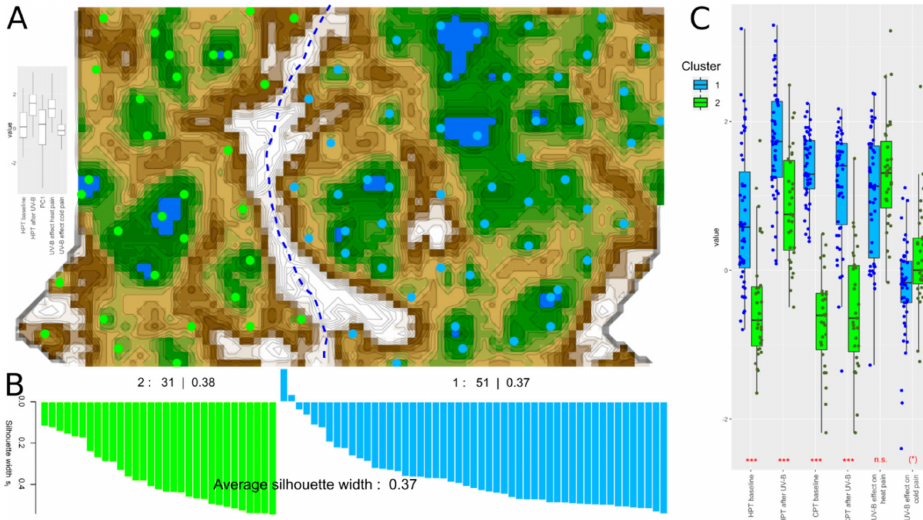
Figure 3. Neural network (emergent self-organizing maps (ESOM) / U-matrix)-based clustering [28] of the pain thresholds to thermal stimuli and the e ff ects of UV-B irradiation, exploring the 82 × 5-sized matrix composed of the values of zHPT baseline , zHPT UVB , UVBE ff Heat , and UVBE ff cold acquired or calculated in 82 subjects, and in addition to PC1 cold being the first component of a PCA of the highly correlated parameters zCPT baseline and zCPT UVB . ( A ) U-matrix visualization of distance-based data structures, using a projection of the data points onto a toroid grid of 4000 neurons where opposite edges are connected. The dots represent the so-called “best matching units” (BMU)—i.e., neurons on the grid that after ESOM learning carried the vector that was most similar to a subjects’ data vector. The U-matrix visualization was colored as a top view of a topographic map with brown (up to snow-covered) “heights” and green “valleys” with blue “lakes”. Watersheds indicate borderlines between di ff erent clusters. Two clusters emerged in this way, separated by the white “mountain ridge” in the center of the U-matrix. BMUs belonging to clusters #1 or #2 are colored in blue or green, respectively. Some heterogeneity within the cluster can be observed, however without providing a clear separation of a further cluster. The box plot panel to the left of the U-matrix displays the variables submitted to the ESOM-based data projection. ( B ) Silhouette plot [29] indicating how near each subject was to its own cluster relative to the neighboring clusters. Positive values indicate that the sample is away from the neighboring clusters, while negative values indicate that those samples might have been assigned to the wrong cluster because they are closer to the neighboring cluster than to their own cluster. ( C ) Pattern of pain thresholds among the two pain-related phenotypes resulting from the cluster analysis (***: p < 0.001 (uncorrected). (*): p < 0.05 (uncorrected)). The boxes have been constructed using the minimum, quartiles, median (solid line within the box), and maximum. The whiskers add 1.5 times the inter-quartile range (IQR) to the 75th percentile or subtract 1.5 times the IQR from the 25th percentile. The dots indicate single data points, jittered to enhance visibility. Alpha-corrected significant group di ff erences according to paired t -tests are indicated at the bottom of the box pairs. The figure has been created using the R software package (v. 3.6.2 for Linux; http: // CRAN.R-project.org / [25]), and the R libraries “Umatrix” (https: // cran.r-project.org / package = Umatrix [30]), “cluster” (https: // cran.r-project.org / package = cluster [31]) and “ggplot2” (https: // cran.r-project.org / package = ggplot2